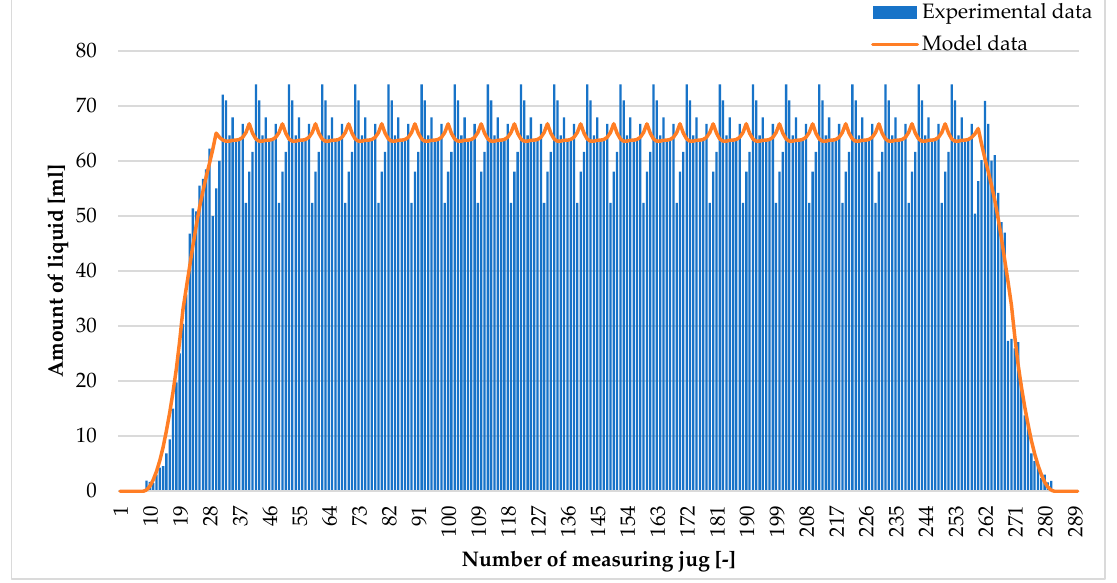
Appl. Sci. 2023 , 13 , x FOR PEER REVIEW Figure 1. Spray fallout distribution for XR 110 02 nozzles. Figure 1. Spray fallout distribution for XR 110 02 nozzles.